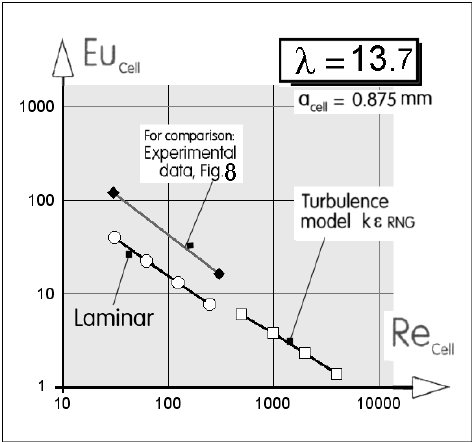
Figure 12. Computed pressure drop results in the co-ordinates from Figure 8, obtained with very short passage lengths.